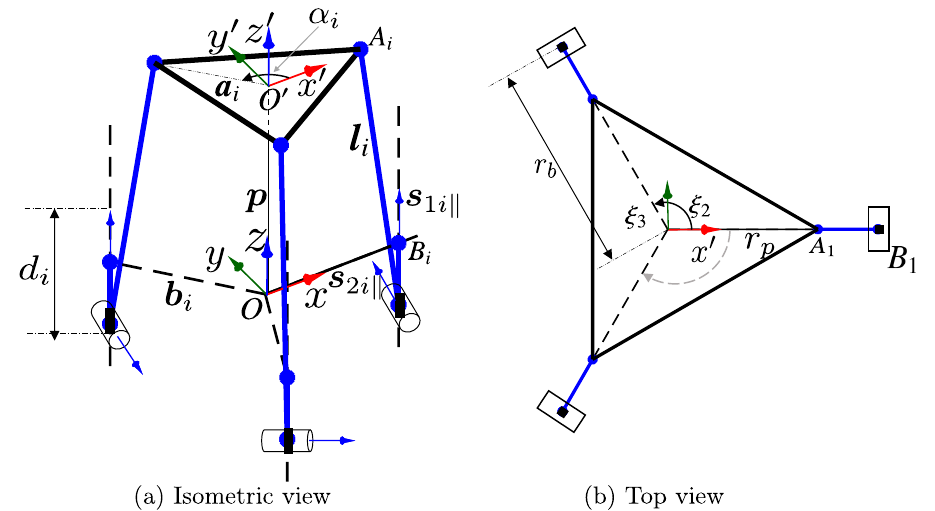
Figure 3. Kinematic architecture of the 3-PvRS